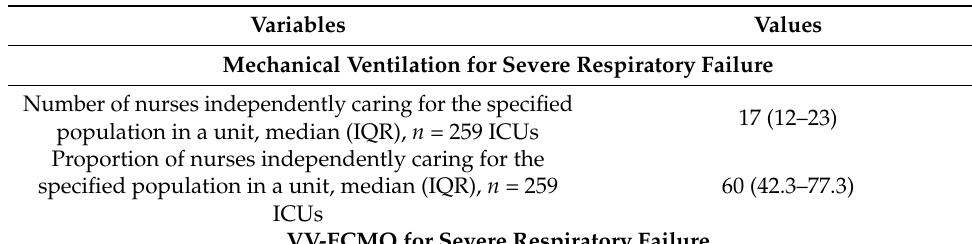
Table 2. Number of nurses independently providing care for mechanical ventilation and VV-ECMO for patients with severe acute respiratory failure.